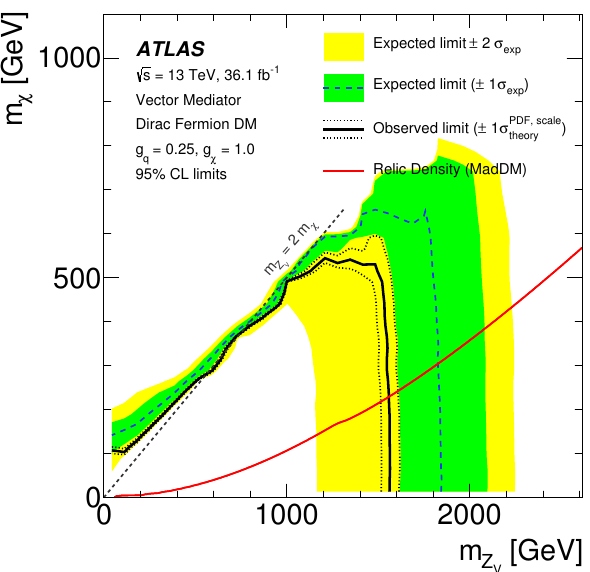
Figure 6 . Observed (solid line) and expected (dashed line) exclusions at 95% CL on the vector mediator models with g q = 1 = 4 ; g (cid:31) = 1 : 0 and minimal mediator width, as a function of the assumed mediator and DM masses. The regions within the drawn contours are excluded. The red curve corresponds to the set of points for which the expected relic density is consistent with the WMAP measurements (i.e. (cid:10) h 2 = 0 : 12), as computed with MadDM [94]. The region on the right of the curve corresponds to higher predicted relic abundance than these measurements. The dotted line indicates the kinematic limit for on-shell production m Z = 2 (cid:2) m (cid:31) . V